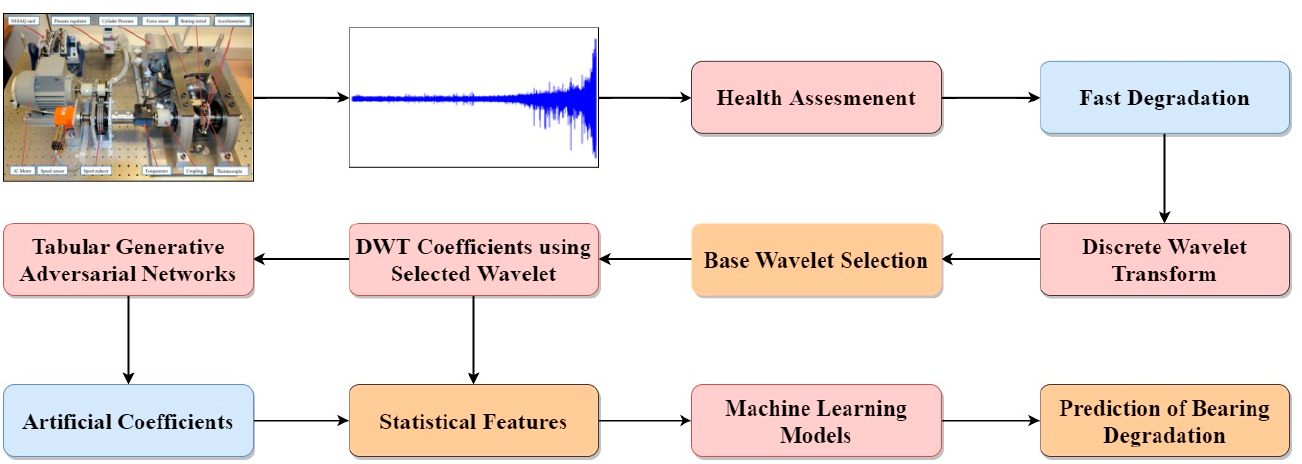
Figure 1. Flow chart of proposed methodology.